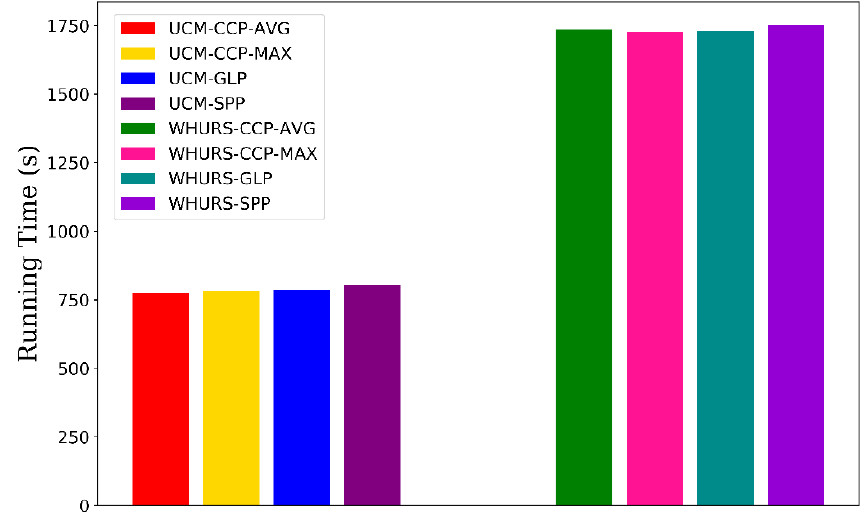
Figure 9. The time consumption of training models with different pooling methods on the UCM and WHU-RS datasets. The AVG, MAX, and GLP in the labels indicate the average aggregate, the max aggregate, and the global pooling.